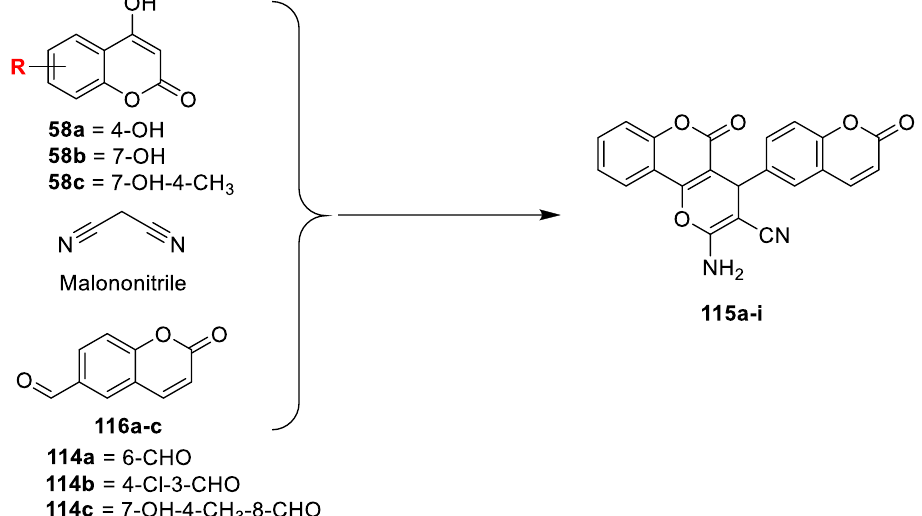
Scheme 22 . Schematic representation of biscoumarin derivatives fused with dihydropyran ring. Re- produced and adapted with permission from ref. 38. Copyright 2018, John Wiley and